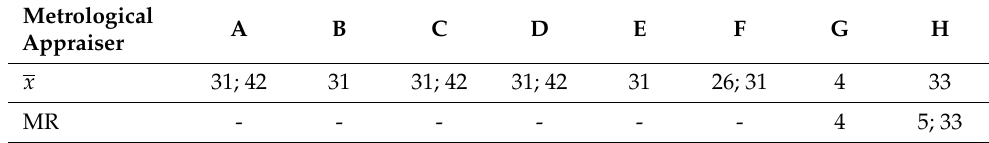
Table 6. Shafts out of control limits indicated by x and MR control charts (the shaft No.).